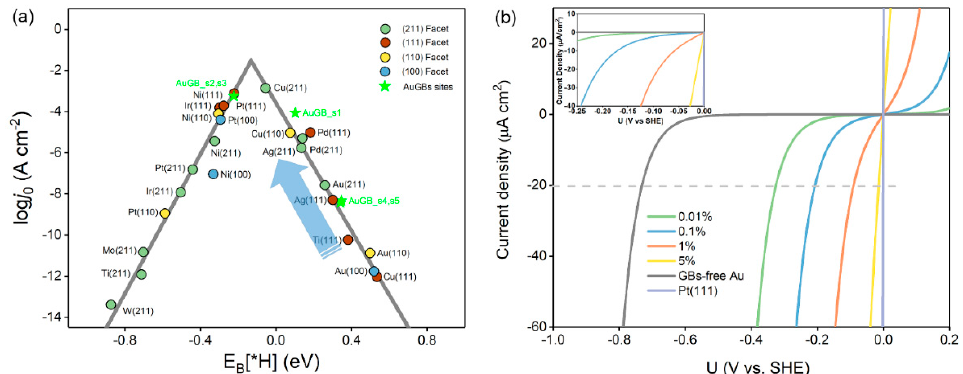
Figure 3. ( a ) Computational exchange current density (log ( j 0 )) for hydrogen evolution over Au GB sites, and various metal surfaces plotted as a function of the hydrogen binding energy. ( b ) Current density of hydrogen evolution as a function of the applied potentials for Au(110) with varying concentrations of GBs on Au(110), and Pt(111) is presented for comparison. The inset presents a magnified version of the plot.